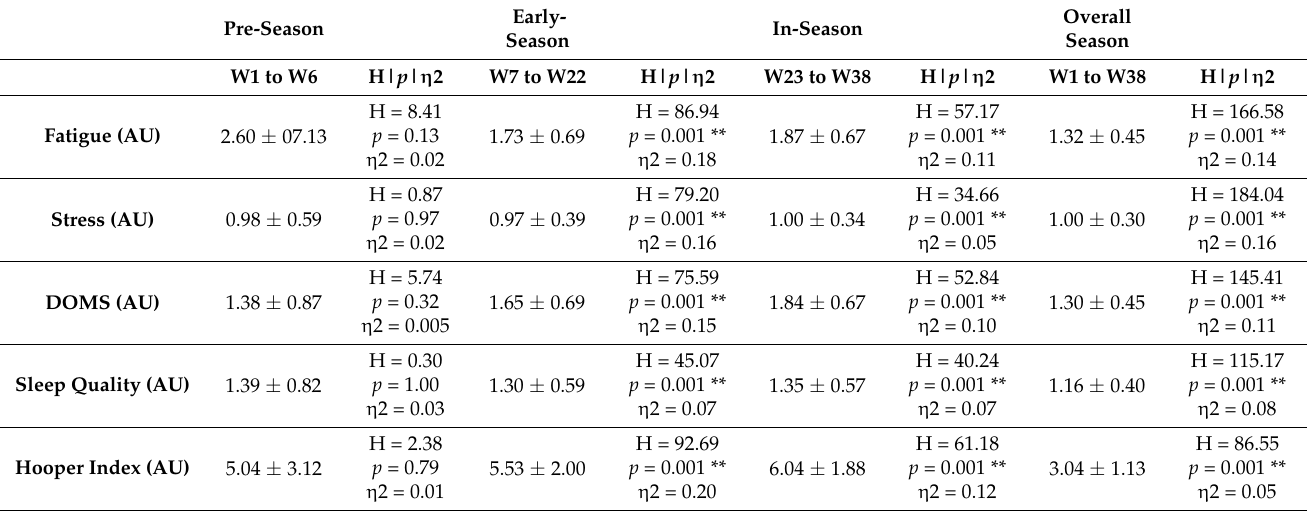
Table 3. Well-being variations from preseason, early-season, in season and